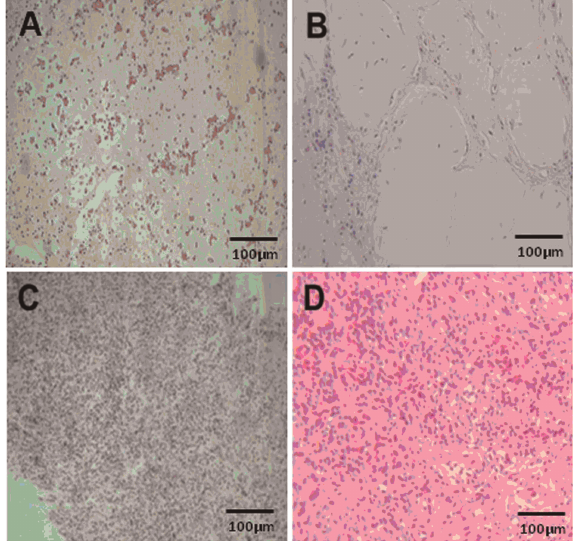
Figure 4. Evaluation of the quasi-natural cell block. ADMS cells were mixed with Matrigel TM gel to transplant the mixture in a conventional approach and tissue sections were prepared for histochemical staining ( A, B ). The quasi-natural cell block ( C, D ) was manipulated and histologically evaluated in comparison with the conventional method. In the conventional method, H&E staining showed mostly scaffold materials with a few encapsu- lated cells in the mixture before transplantation ( A ) and after transplantation ( B ). In the quasi-natural cell block, however, much higher densities of ADMS cells were observed before transplan- tation ( C ) as well as after transplantation ( D